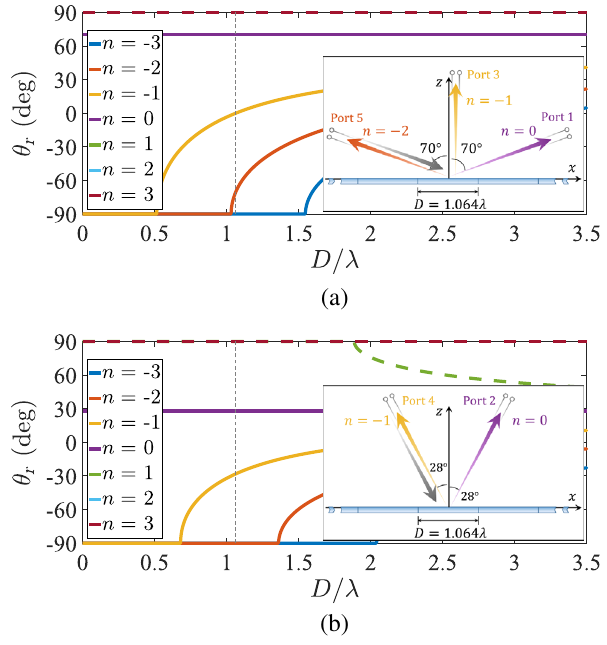
FIG. 11. The reflection angles of different Floquet harmonics for a five-channel retroreflector. Here, the reflector periodicity D ≈ 1 . 064 λ is chosen. Illumination is at (a) θ (b) θ i ¼ 28 °. The grey dashed line indicates the periodicity of the reflector. For clarity, only seven harmonics are